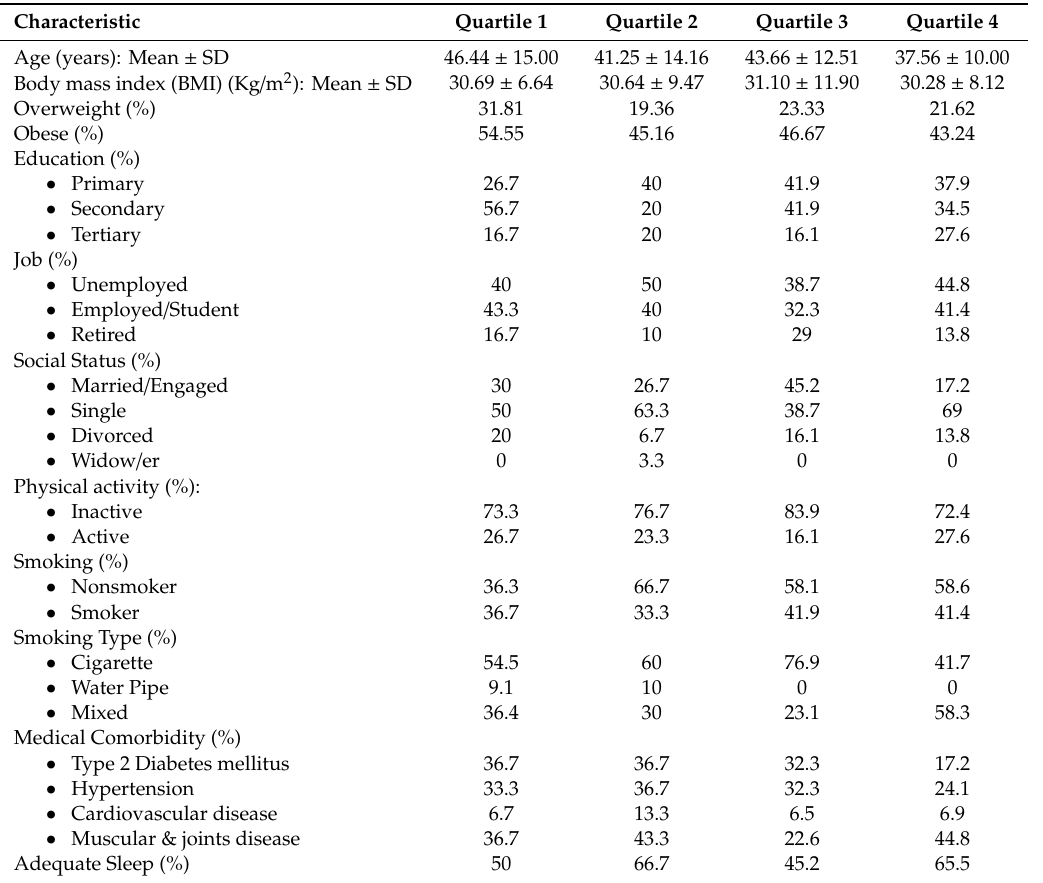
Table 2. Characteristics of schizophrenia case participants across the quartiles of energy-adjusted Dietary Inflammatory Index